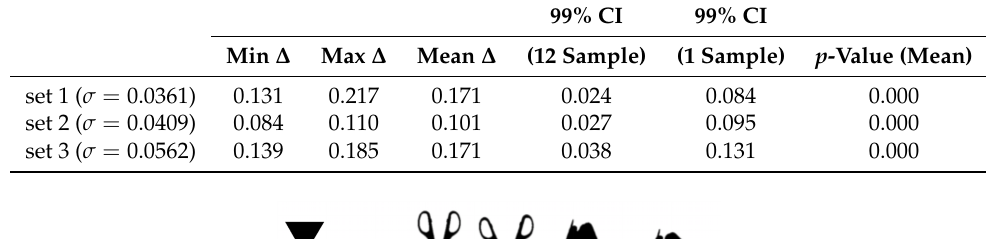
Table 5. p -test for NMI differences. Pooled standard deviations are used.